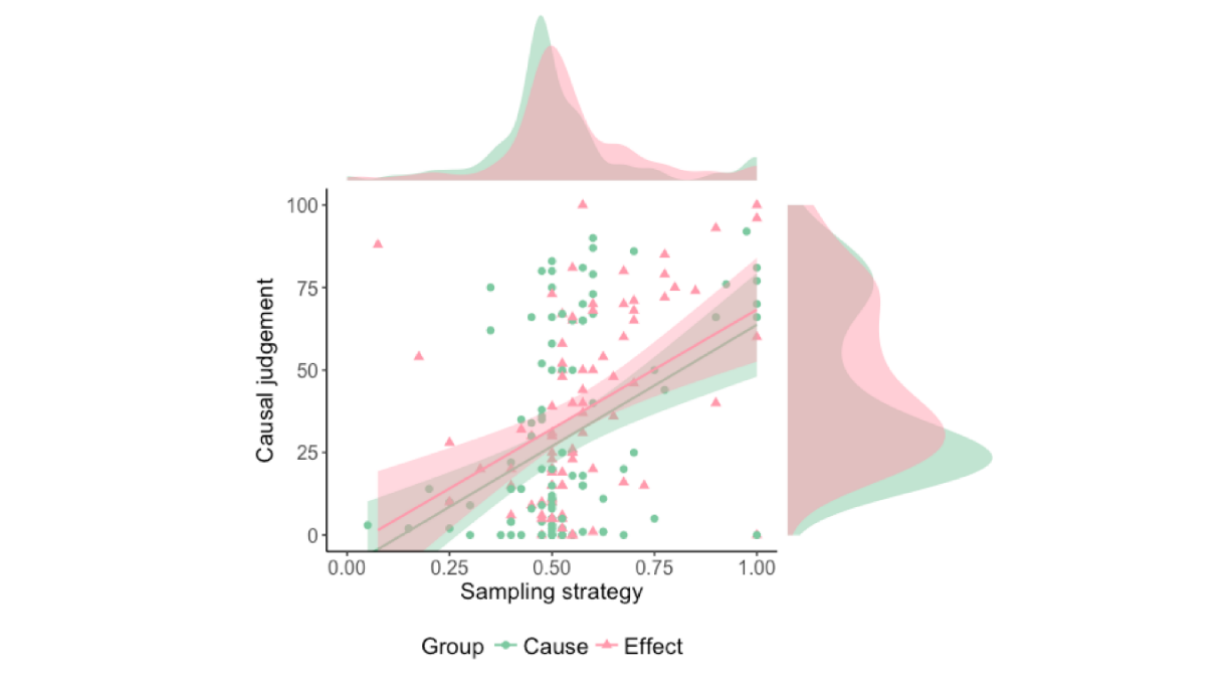
Figure 4. Causal estimations as a function of sampling strategy index and